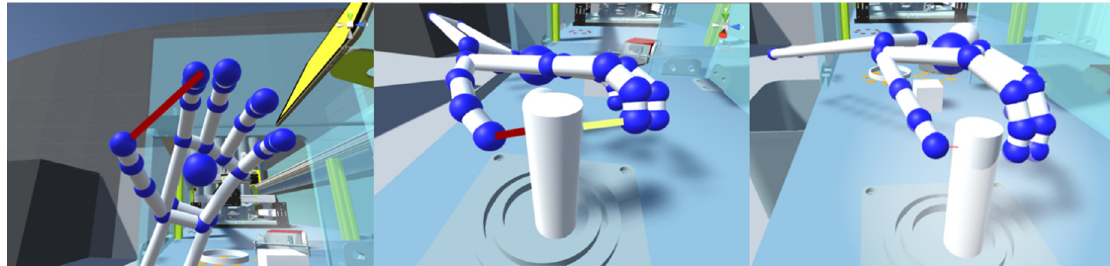
Figure 4. Visualized distance measurements between the hand and the virtual object.